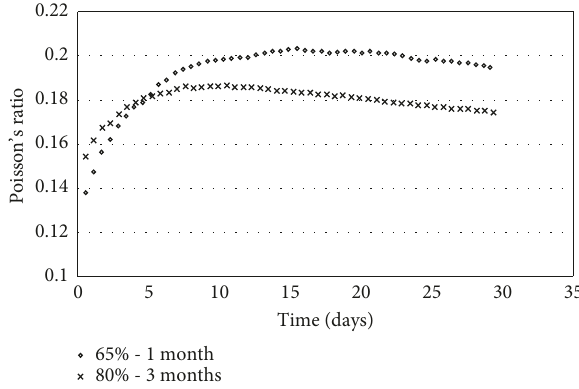
Figure 12: Effective Poisson’s ratio calculated from combined elastic and creep strains vs.